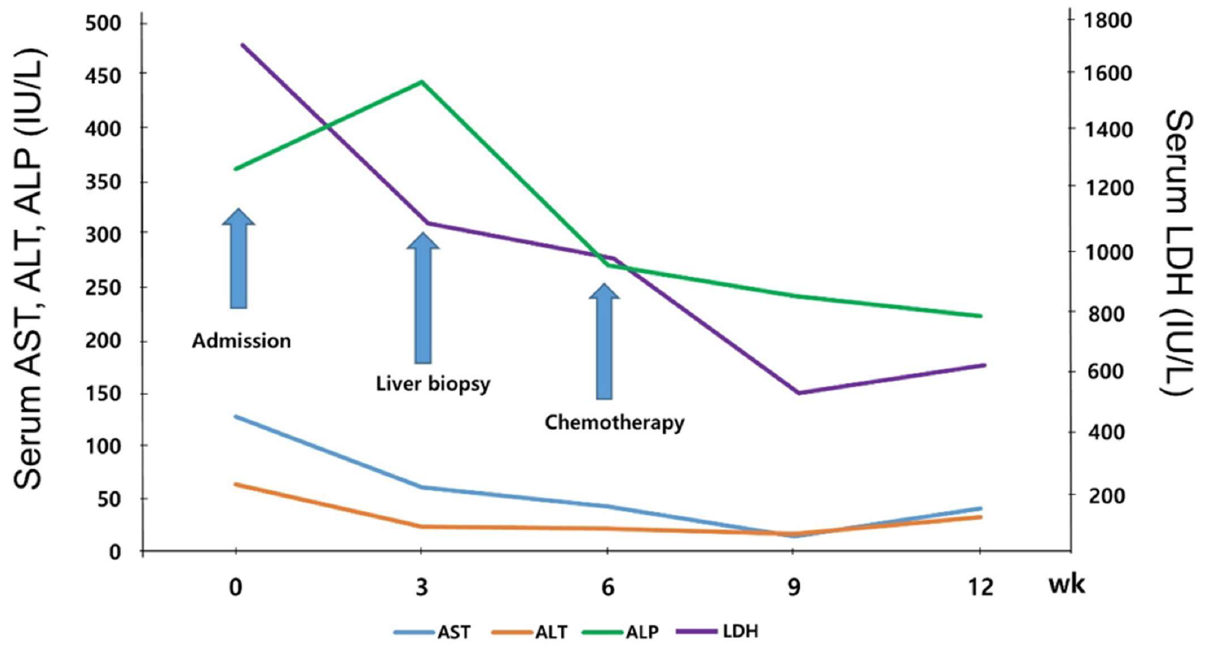
Figure 4. Clinical course of the patient. Aspartate aminotransferase (AST), alanine aminotransferase (ALT), alkaline phosphatase (ALP), and lactate dehydrogenase (LDH) levels markedly decreased after chemotherapy.